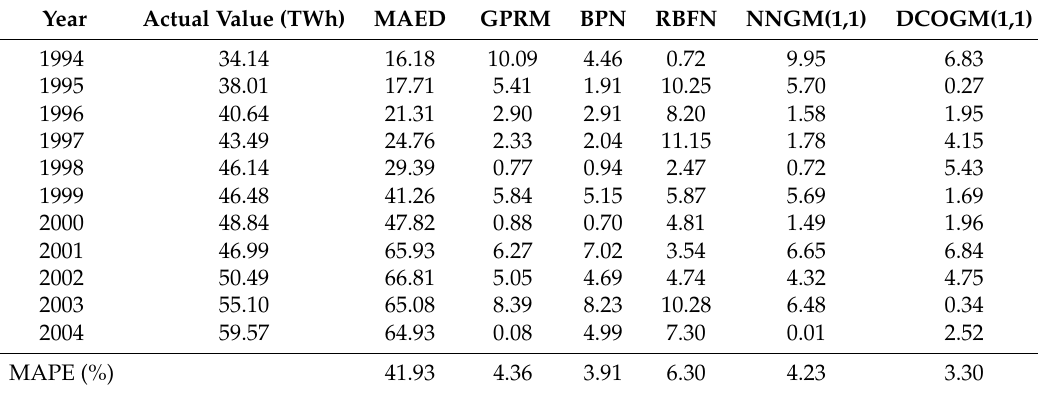
Table 3. APE and MAPE obtained by different methods for industrial electricity consumption.